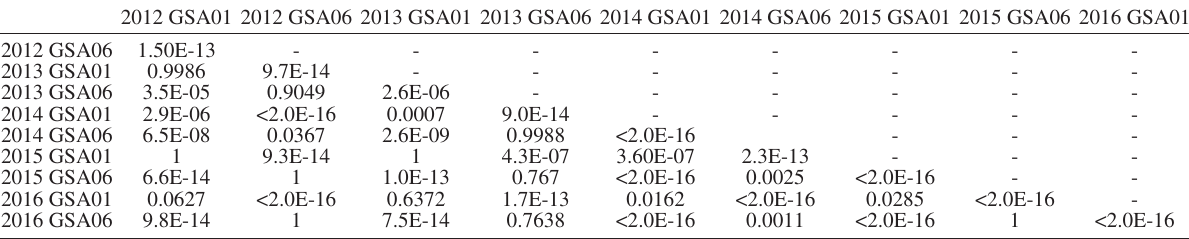
Table 2. – Tukey and Kramer (Nemenyi) post hoc test